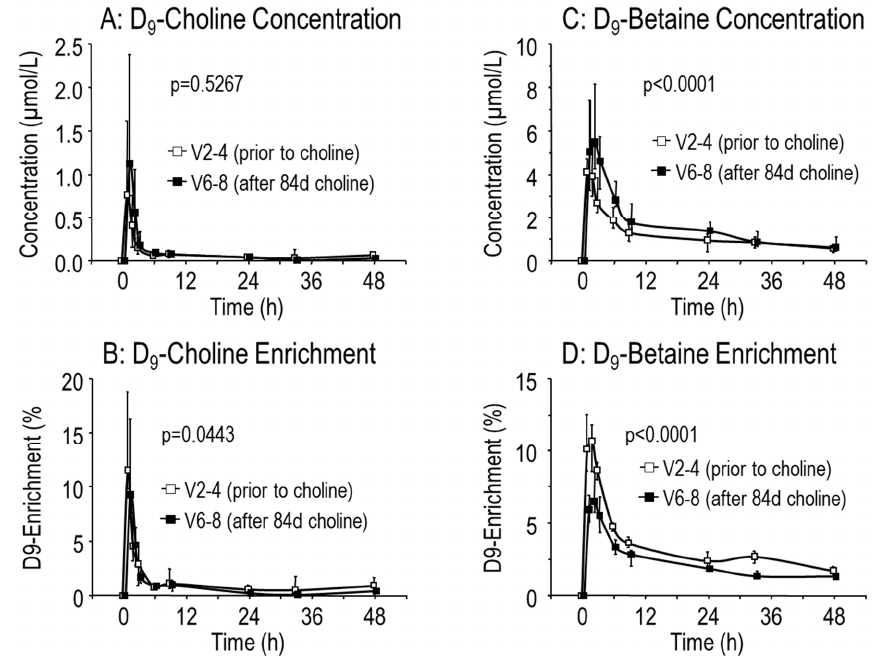
Figure 3. Kinetics of D 9 -Choline and D 9 -Betaine prior to (visit 2–4 [V2–4], white symbols) and from 12 h after the end of 84 (84–91) days choline supplementation (V6–8, filled symbols). CF patients ( N = 10) were orally supplemented with 3 × 1 g choline chloride for 84 (84–91) d. Prior to (V2, open symbols) and 12 h after the end of supplementation (V6, filled symbols) patients were spiked orally with 3.6 mg/kg body weight [D 9 -methyl]choline chloride (D 9 -choline) and the kinetics of plasma D 9 -choline ( A ) and D 9 -betaine ( C ) concentration and of D 9 -enrichment of choline ( B ) and betaine ( D ) analyzed for 48 h (V2–4 and V6–8, respectively). Data are medians and interquartile ranges from − 5 min to 48 h after D 9 -choline ingestion. Abbreviations: p , significance